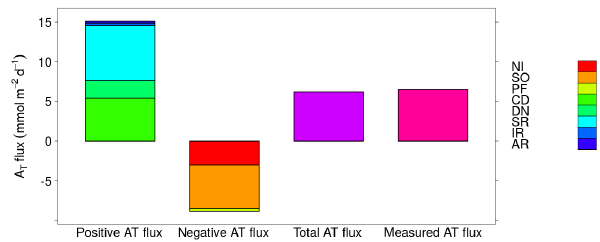
Figure 12. Contribution of different processes to the benthic A T budget in the SNS. For more details on different reaction rates, see the text. NI: nitrification; SO: sulfide oxidation; PF: pyrite forma- tion; CD: carbonate dissolution; DN: denitrification; SR: sulfate re- duction; IR: dissimilatory iron reduction; AR: aerobic respiration. Fluxes in mmolm − 2 d − 1